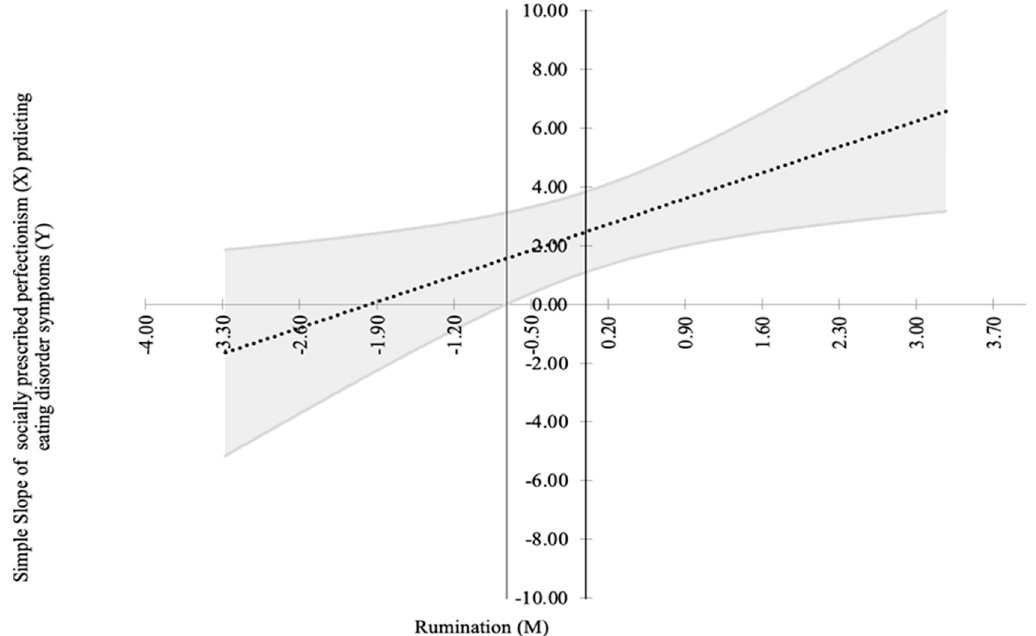
Figure 2. This Johnson-Neyman plot illustrates the simple slope of socially prescribed perfectionism that predicts disor- dered eating at varying degrees of rumination (unadjusted model). Socially prescribed perfectionism and rumination are mean-centered. The dash-dot line denotes the simple slope with 95% confidence bands. The positive relation between socially prescribed perfectionism and disordered eating is significant only at higher values of rumination.